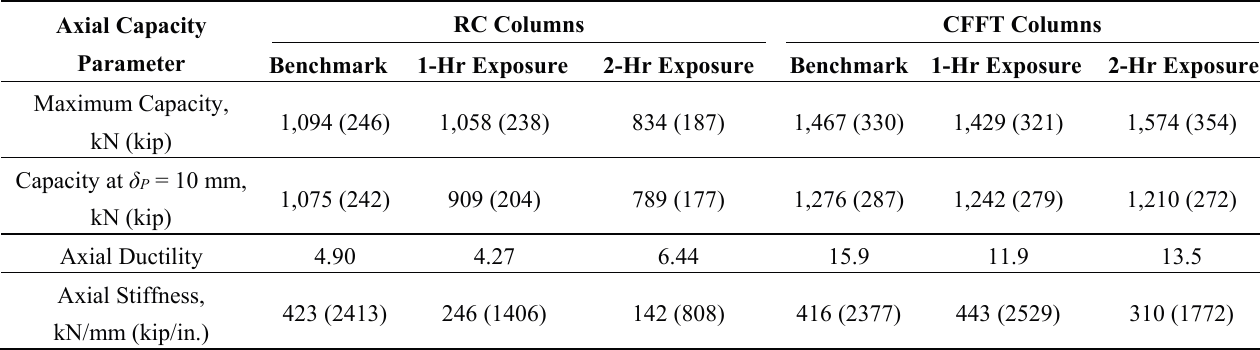
Figure 15. Load-deformation relationships of RC and CFFT fire damaged columns. Table 3. Summary of test capacity results of fire damaged